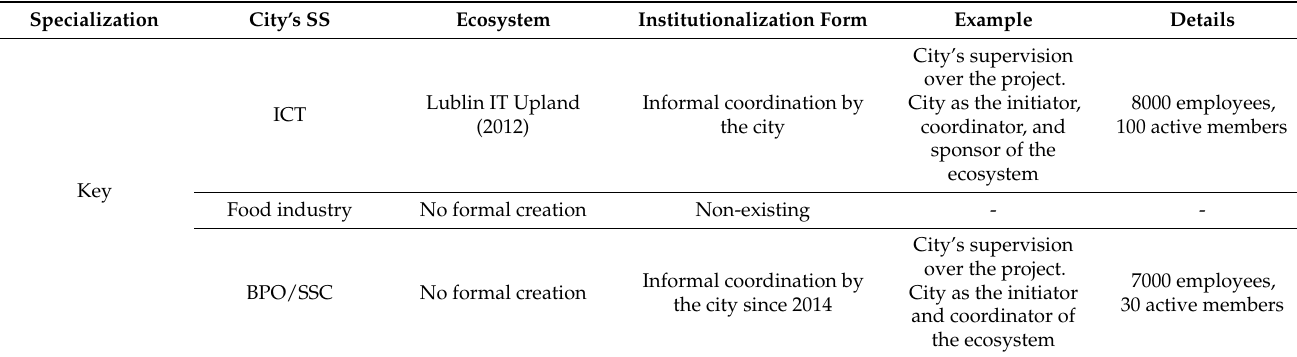
Table 2. Key and complementary smart specializations and business ecosystems in